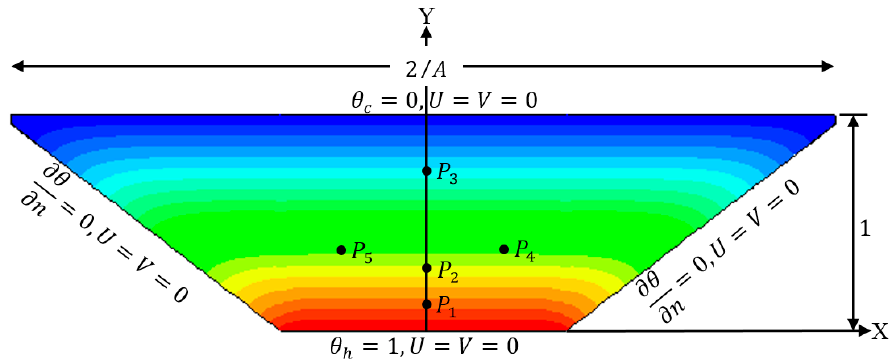
Figure 1. Schematic of physical domain with nondimensional boundary conditions with the monitoring points P 1 (0, 0.133), P 2 (0, 0.4), P 3 (0, 0.8), P 4 (0.4, 0.51), and P 5 ( − 0.4, 0.51), which are utilized in the resulting figures.